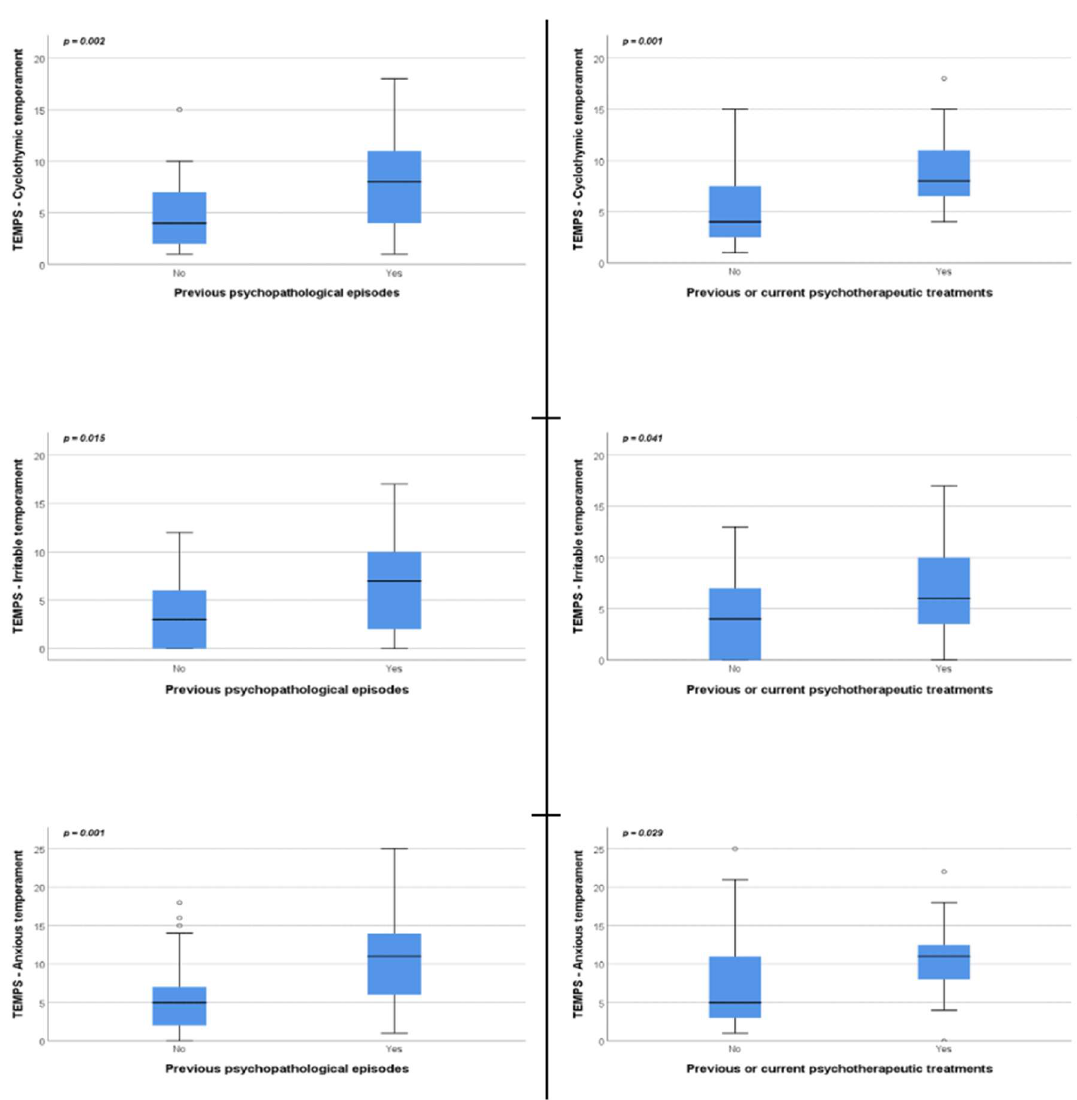
Figure 1. Sample Z-score temperament distribution (N = 55).